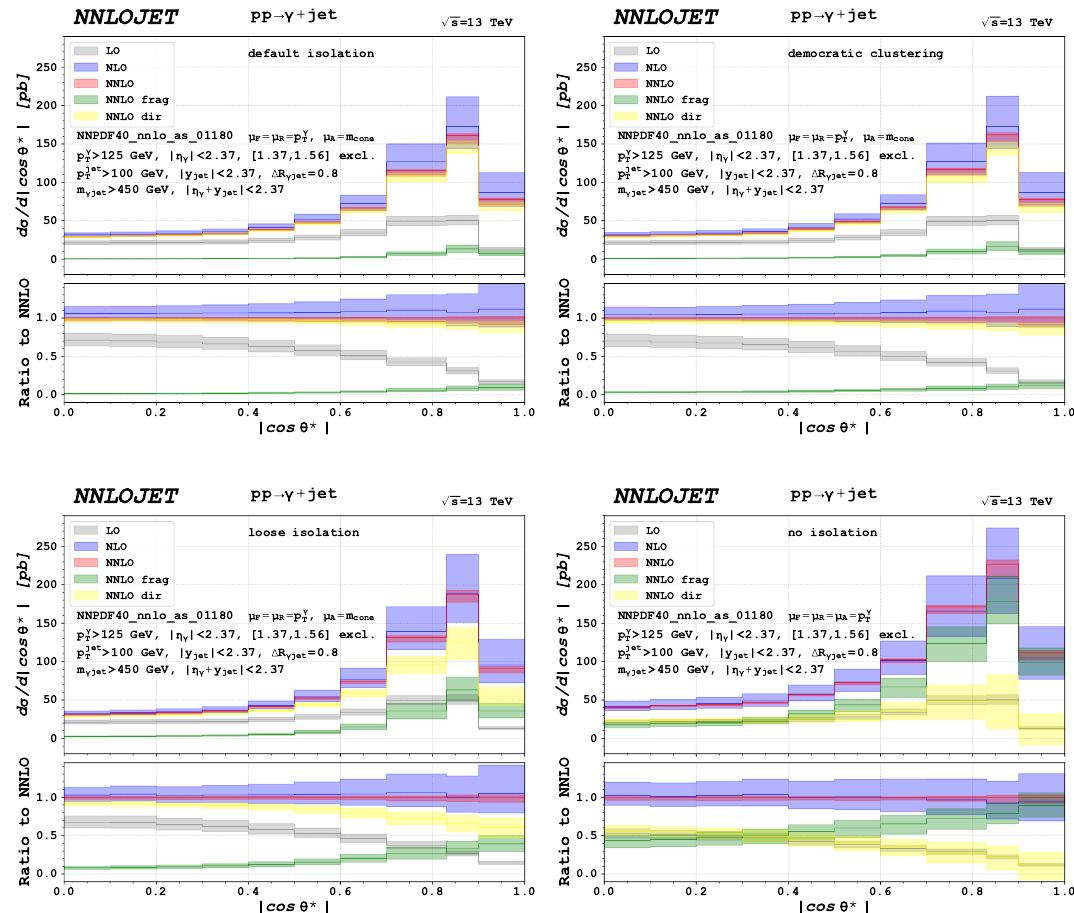
Figure 17. Decomposition of the cross section differential in | cos θ ∗ | . Results obtained with the default isolation, a loose isolation, democratic clustering and without isolation are